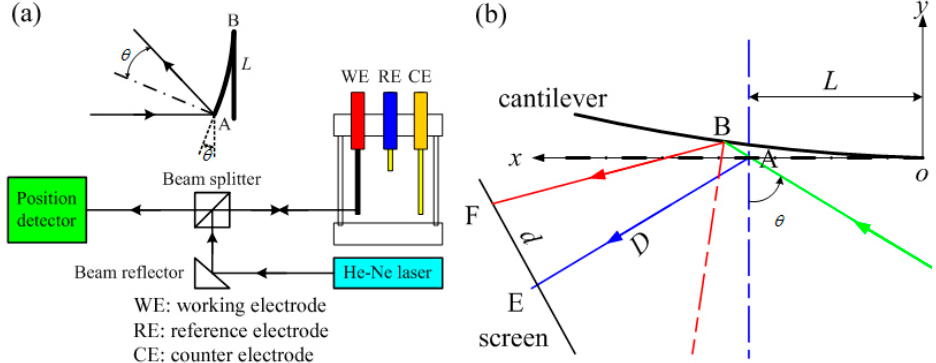
Figure 2. Block diagram of in situ stress measurements for a film object: ( a ) a thin-film electrode [24]; and ( b ) a cantilever [25].